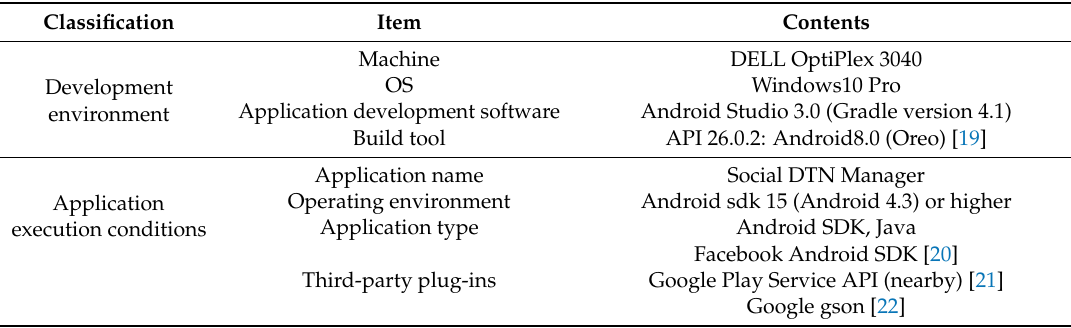
Table 7. Development environment and application execution